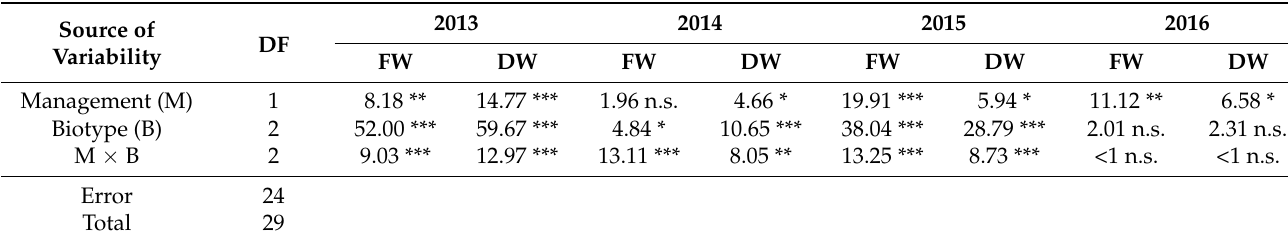
Figure 2. Average number per plant of stems with flowers (blue bars) and vegetative stems (orange) in 3 H. perforatum biotypes cultivated from 2014 to 2016 in pots and in open field. Error bars represent the standard deviations of each mean. Vertical bars indicate the standard deviations of the total number of stems (flowered + vegetative). Table 3. Results of ANOVA (F values) for the fresh (FW) and dry (DW) weight of aerial plant biomass from 2014 to 2016 according to crop management (M) and biotype